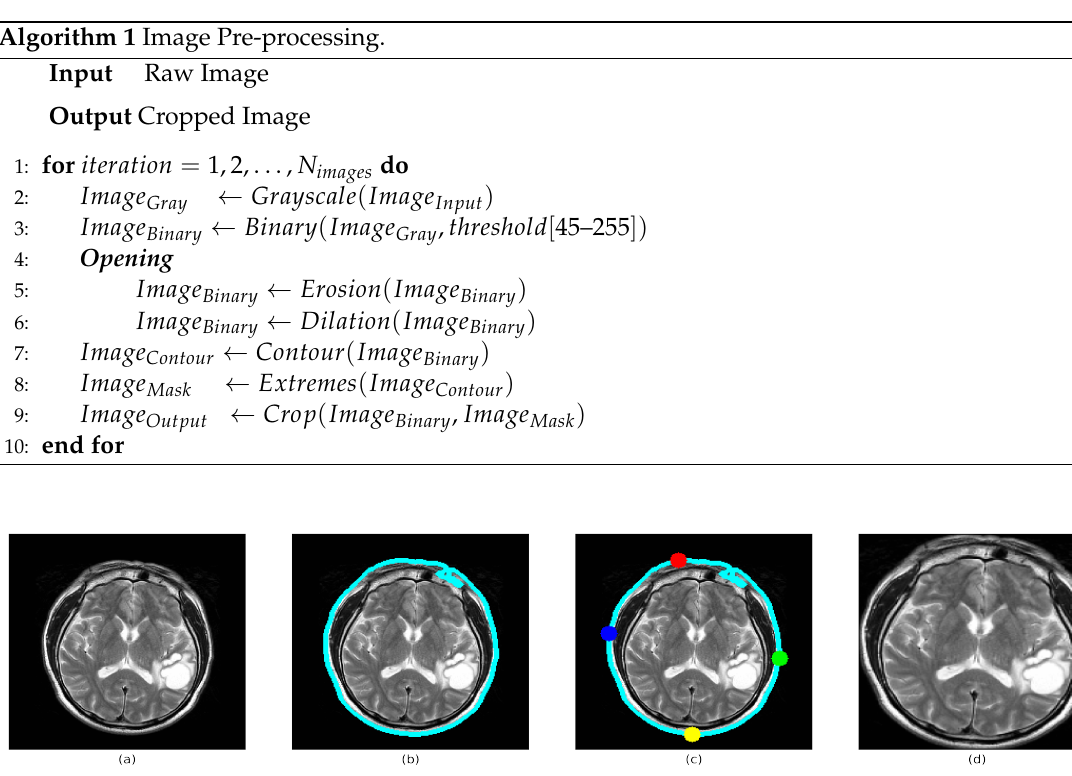
Figure 2. ( a ) Original Image: Section of brain from a MRI scan ( b ) Finding largest contour: Detecting the overall shape of the skull structure. ( c ) Calculating extreme points of contour: Selecting the best points to fit the entire brain into the frame with minimum loss of data ( d ) Cropping based on extreme points: The brain structure from the MRI image is the main focus area of the new image.